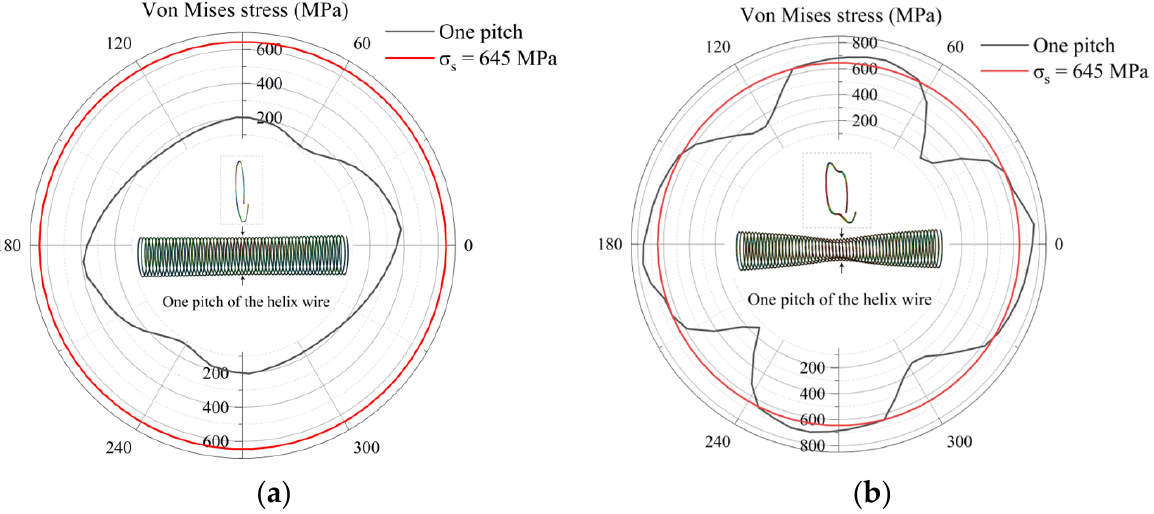
Figure 10. Von Mises stress of the helix wire at cross section of the hose: ( a ) with non-collapse, ( b ) after collapsed.